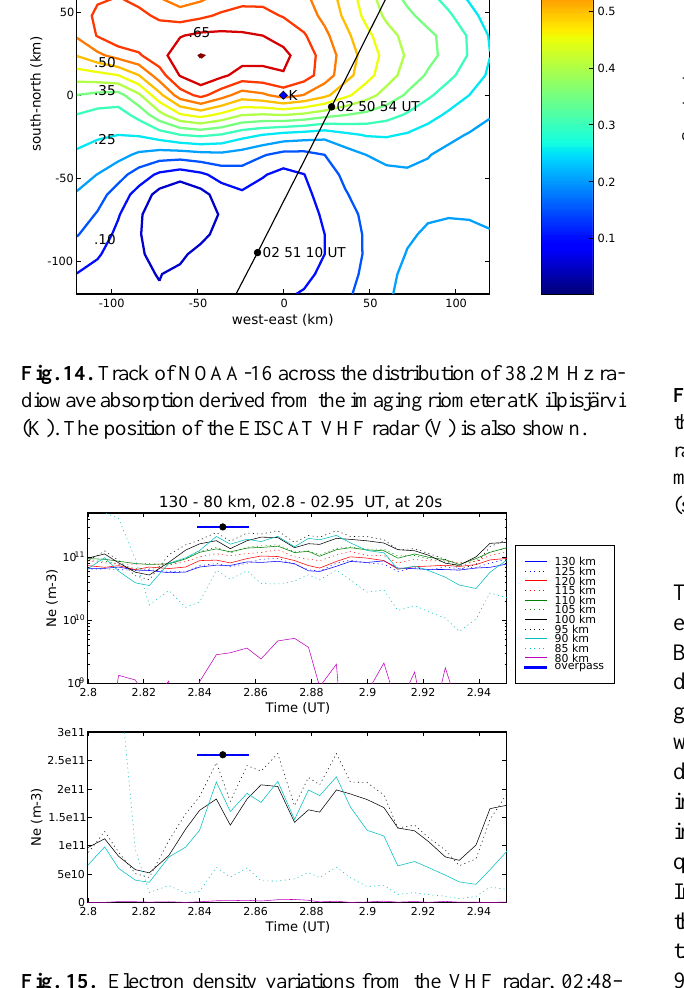
Fig. 15. Electron density variations from the VHF radar, 02:48– 02:57 UT. The time of the overpass and the central time of the IRIS map are marked.